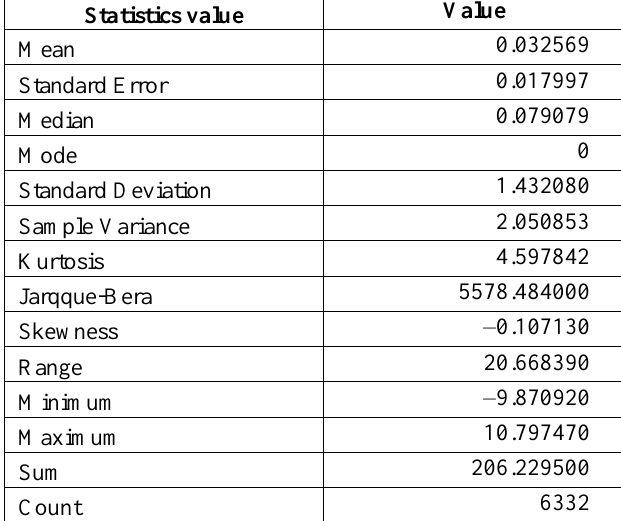
Table 1. Summary Statistics of Daily Returns on the German Stock Market Between 1991 and 2016